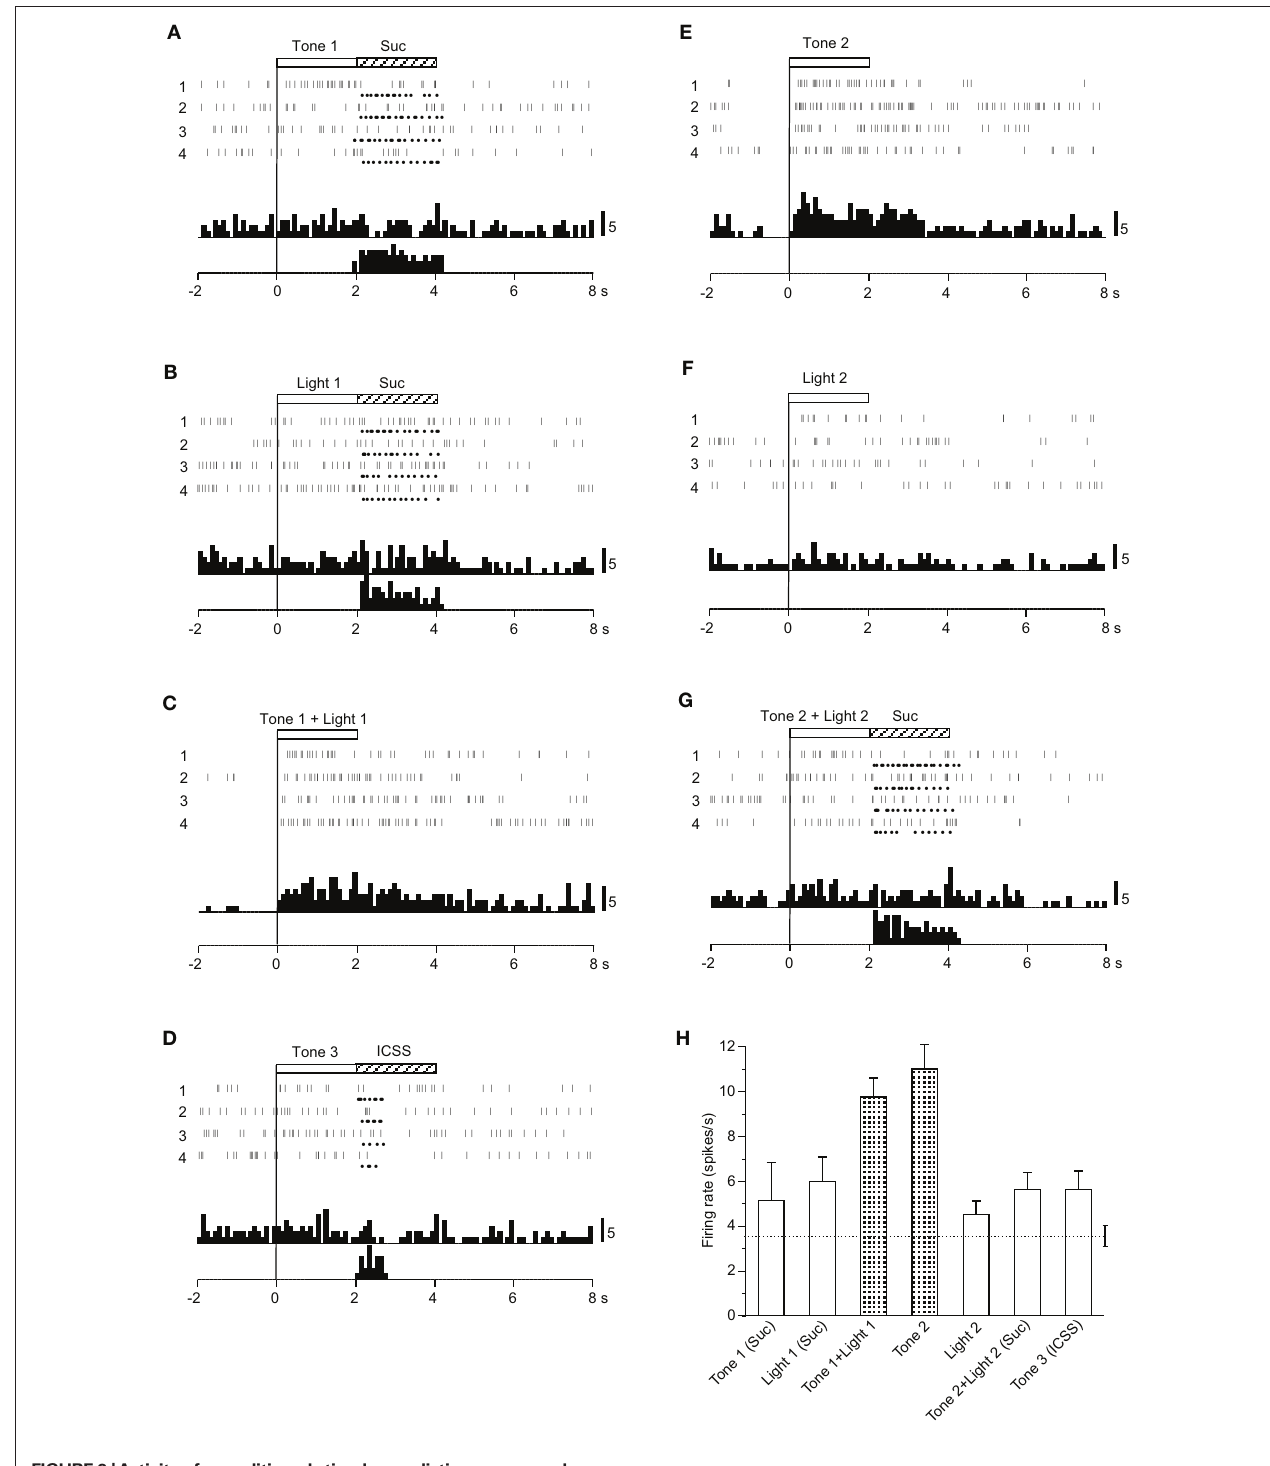
predicting non-reward (F) , and Tone 2 + Light 2 predicting the sucrose solution (g) . Note that neuronal activity increased during presentation of a CS 0 that included the auditory stimulus (i.e., Tone 2 and Tone 1 + Light 1) but not during presentation of a visual CS 0 (Light 2) nor the CS + (Tone 1, Light 1, Tone 3, and Tone 2 + Light 2). (H) Histogram of neuronal responses during presentation of each CS (mean firing rate ± SEM). Other descriptions as in Figure